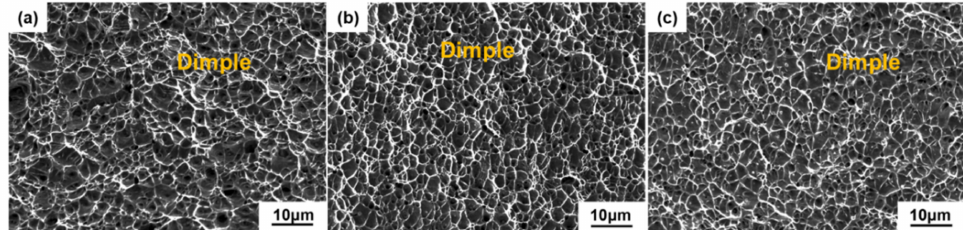
Figure 8. SEM morphologies of tensile fracture surfaces: ( a ) AP, ( b ) AT and ( c ) SA